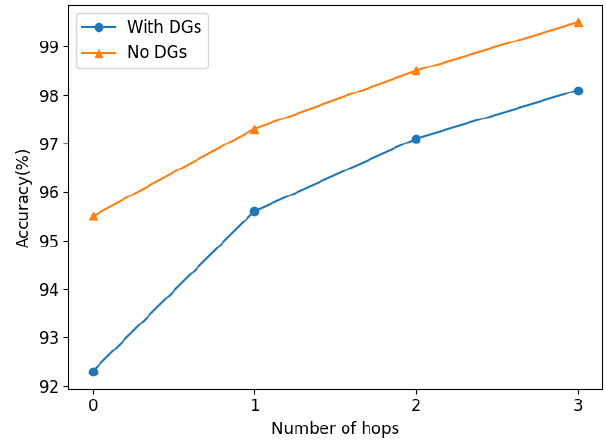
Figure 13. Fault location results with DGs access. Table 6. Comparison results with DGs access.